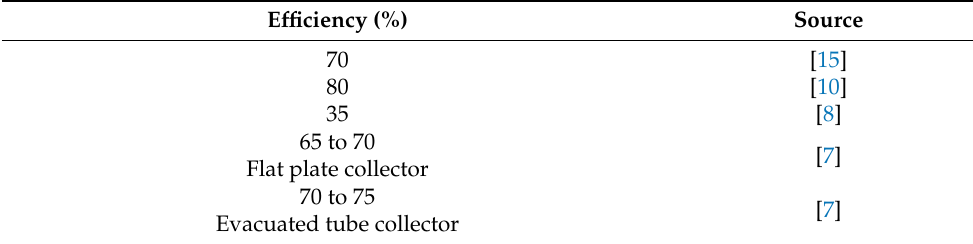
Table 2. Technical energy potential for different cities.